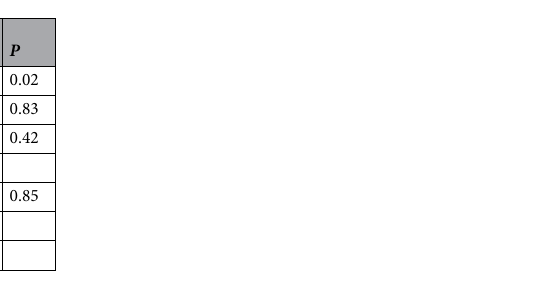
Table 1. Clinical characteristics of patients with or without cervical LNM. LNM: lymph node